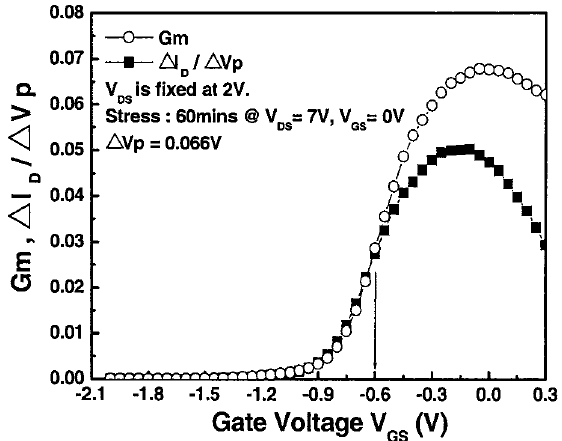
FIGURE 4 D I DS and (cid:2) G m D V p as a function of V GS . The D I DS and G m have been calculated at V DS ¼ 2V. D I DS is the